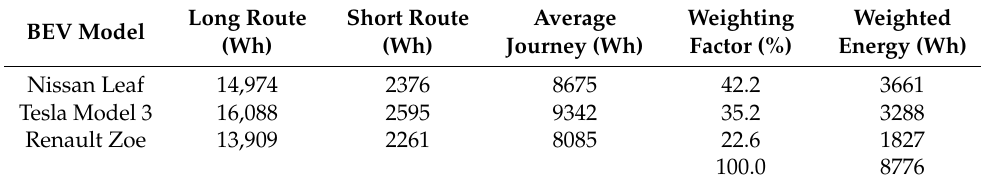
Table 4. Daily average energy